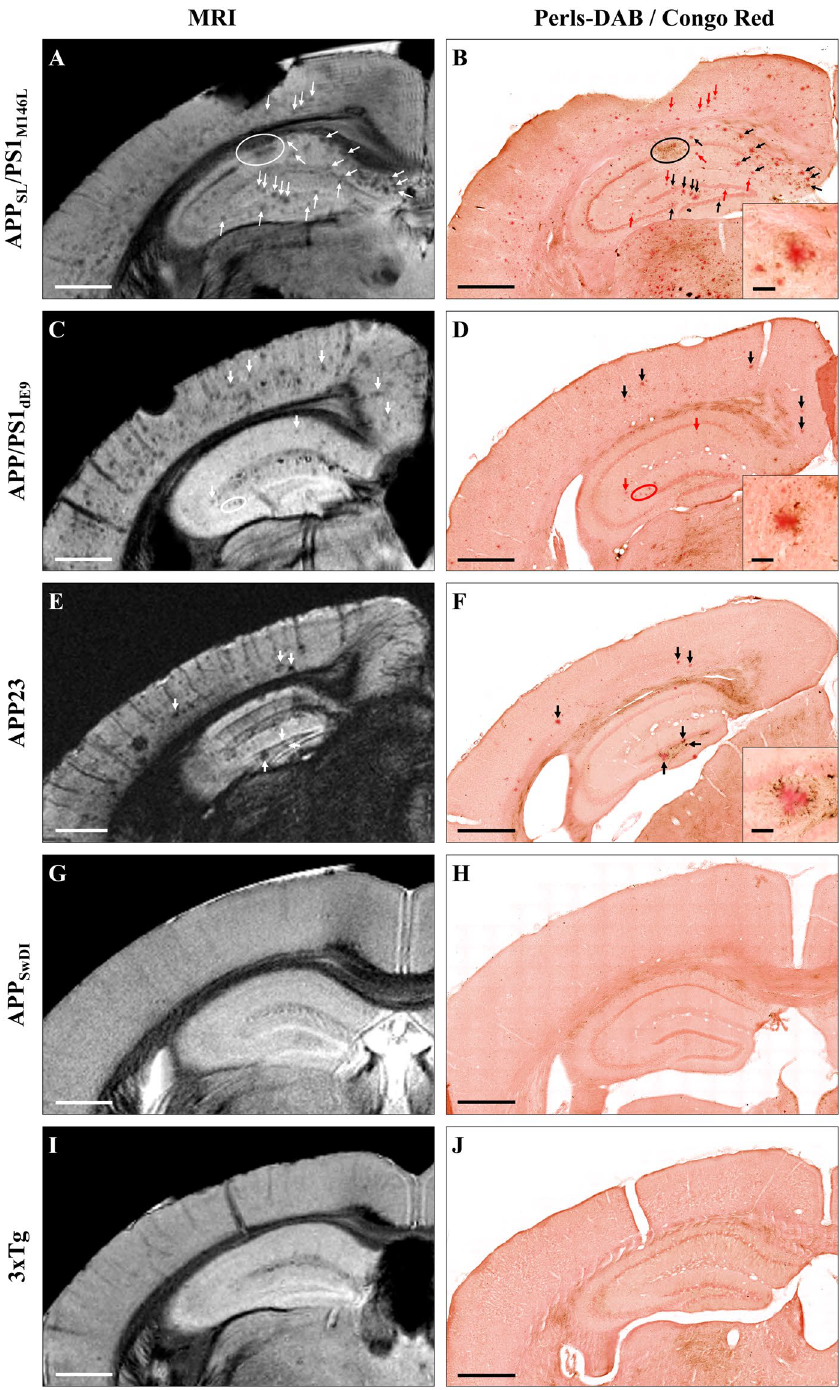
Figure 4. Comparison between detection of amyloid plaques by Gd-stained MRI and histological sections double-stained for amyloid and iron in five mouse strains. Gd-stained MR images (left) were registered with histological sections double-stained for β -amyloid (Congo red) and iron (Perls-DAB) (right) in APP SL /PS1 M146L ( A , B ), APP/PS1 dE9 ( C , D ), APP23 ( E , F ), APP SwDI ( G , H ) and 3xTg ( I , J ) mice. Hypointense spots (white arrows and circles) were visible in the MR images of APP SL /PS1 M146L ( A ), APP/PS1 dE9 ( C ) and APP23 ( E ) mice. They could be registered with congophilic amyloid plaques on histological sections ( B , D , F , black and red arrows and circles). No congophilic plaques were detected in APP SwDI ( H ) and 3xTg ( J ) mice. Iron staining revealed iron deposits that co-localize with amyloid plaques (black arrows and circles) in APP SL /PS1 M146L ( B ), APP/PS1 dE9 ( D ) and APP23 ( F ) mice. Some other plaques were iron-free (red arrows and circles) and were also detectable by MRI indicating that iron is not necessary for their detection. No iron accumulation was observed in APP SwDI ( H ) and 3xTg ( J ) mice. Scale bars: 500 µ m for main images and 50 µ m for